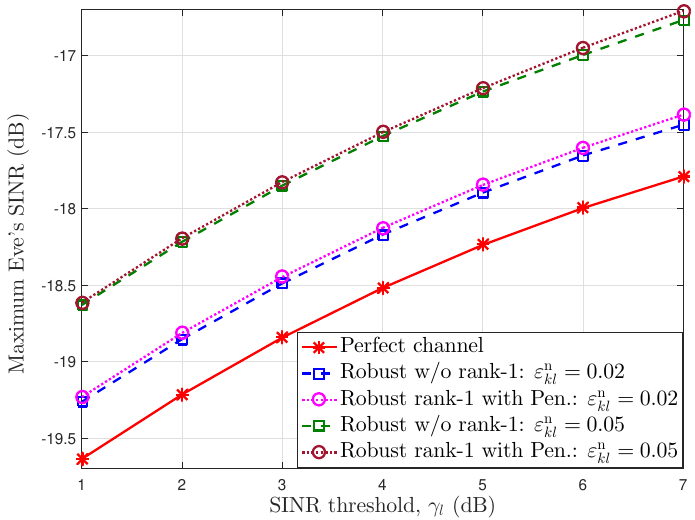
Figure 4. The maximum Eve’s SINR according to the SINR threshold at the